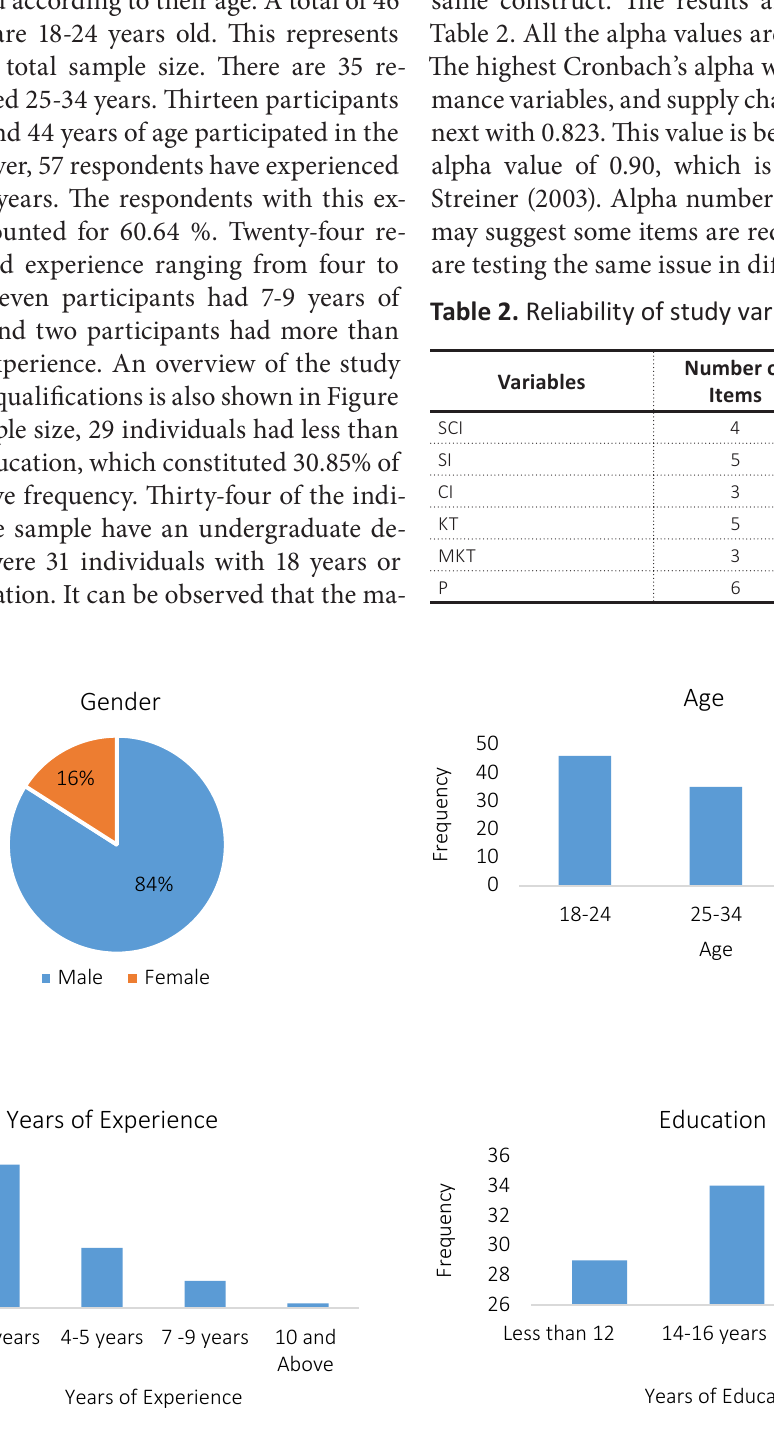
Figure 2. Descriptive statistics for participants’